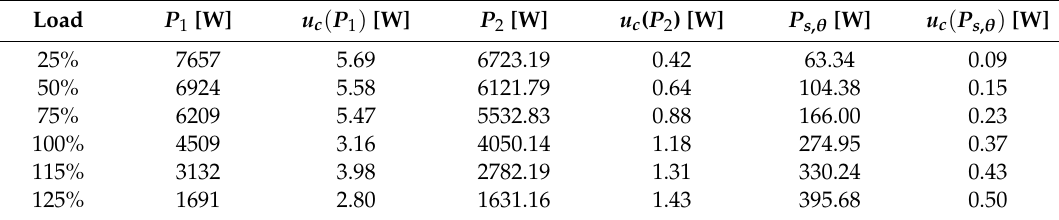
Table 1. Experimental results: input power, output power, and stator winding losses with uncertainties.